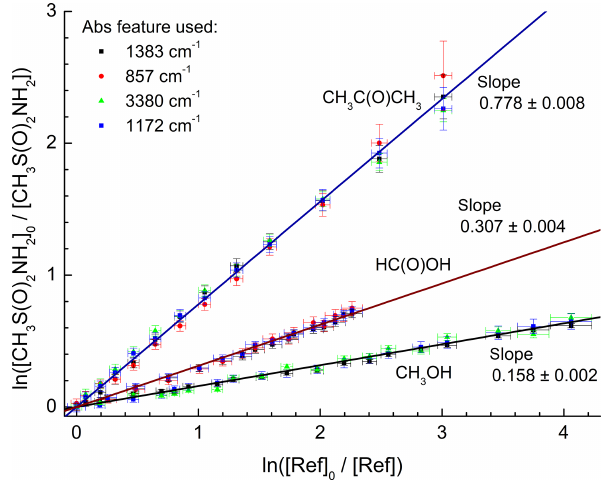
Figure 3. Relative depletion factors for MSAM and the reference compounds CH 3 C ( O ) CH 3 , HC ( O ) OH, and CH 3 OH obtained at room temperature and a total pressure of 700Torr of air. The differ- ent absorption bands of MSAM used in the analysis are indicated. The slopes are equal to the ratio of rate coefficients k 4 /k ref as de- fined in Eq.